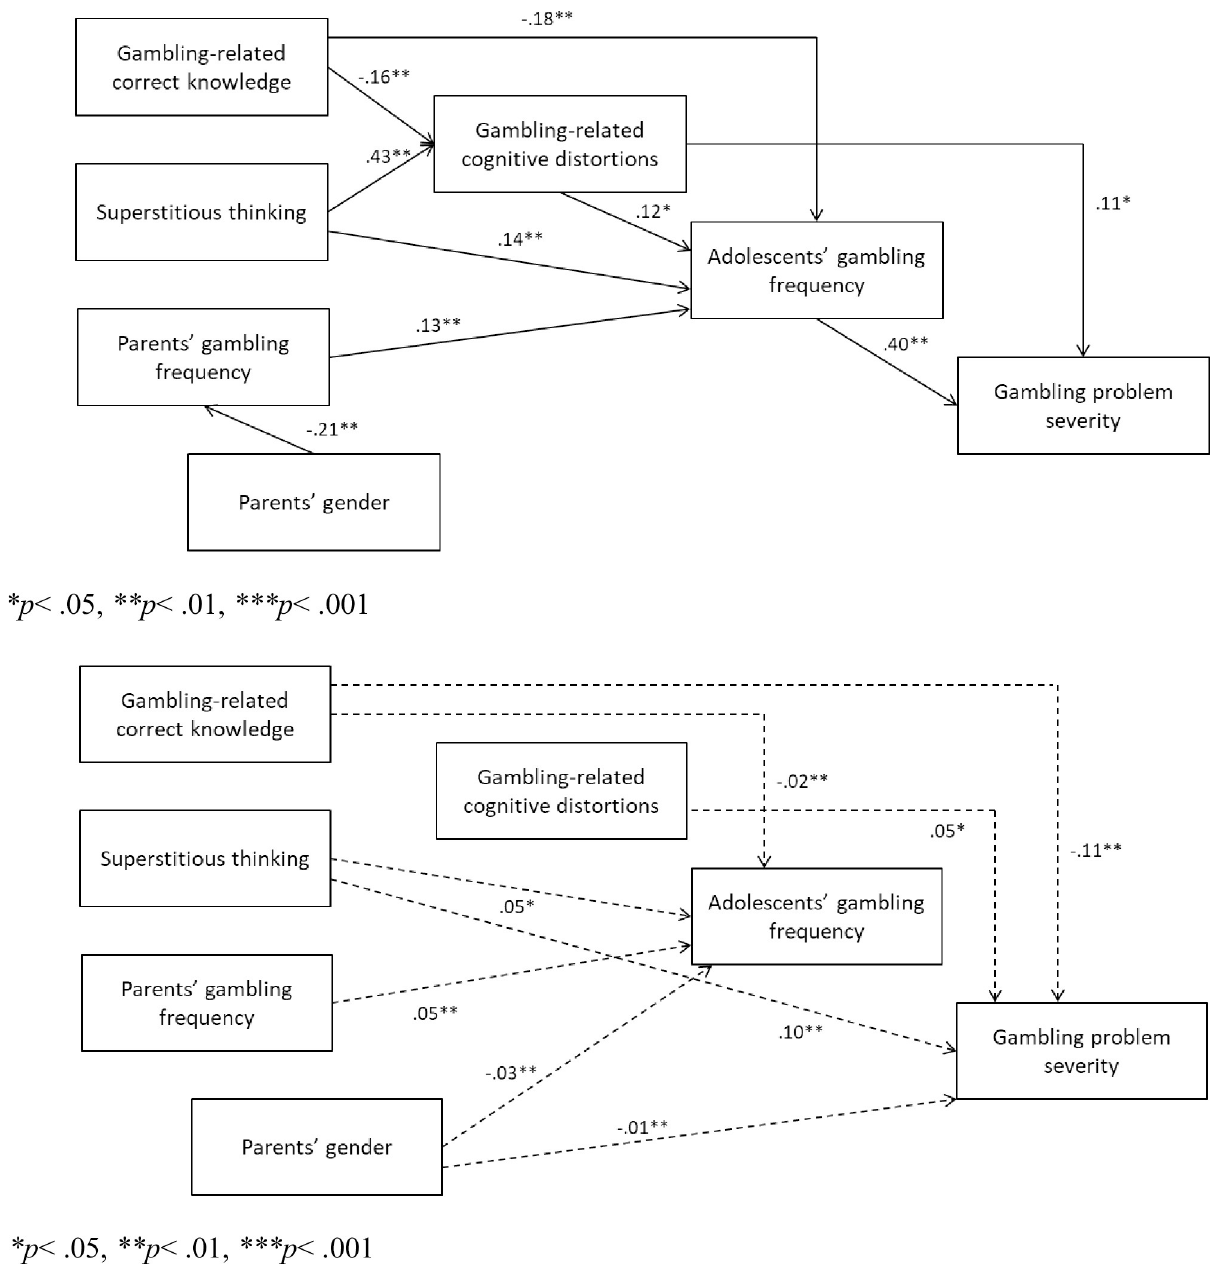
Fig 1. a. Path model with direct effects among the variables, and by including parents’ gender (1 = man, 2 = woman). b. Path model with indirect effects among the variables, and by including parents’ gender (1 = man, 2 = woman). � p < .05, �� p < .01, ��� p < .001.